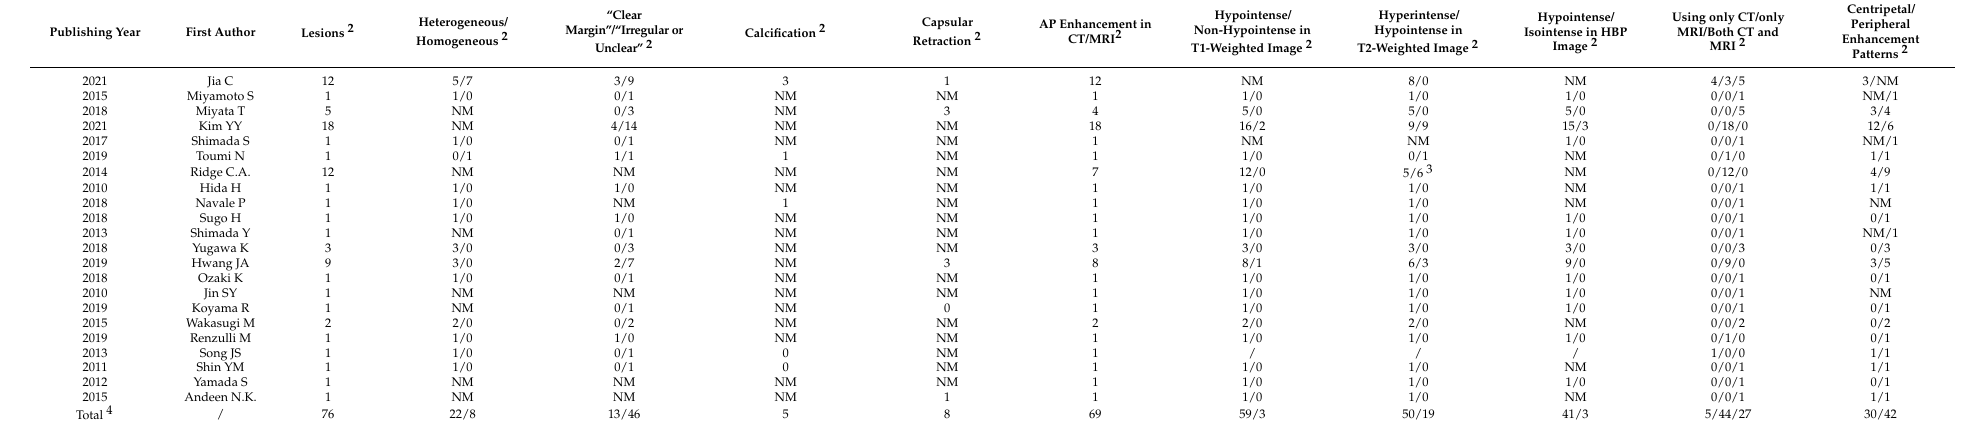
Table 3. Review of CT/MR imaging features for HSH 1